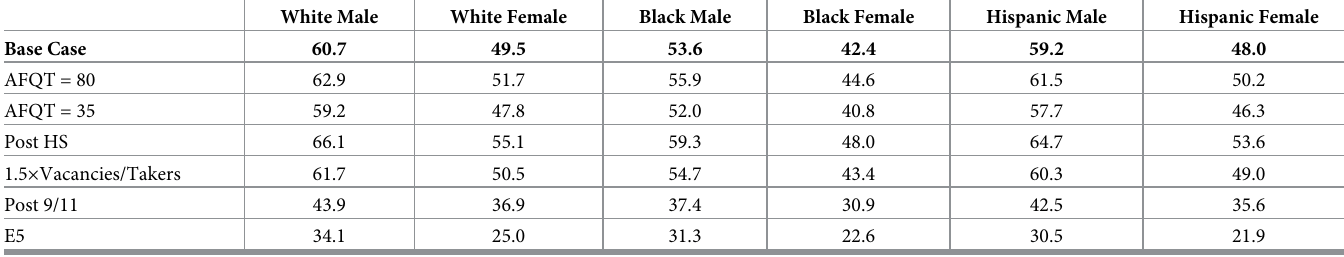
Table 4. Promotion simulations